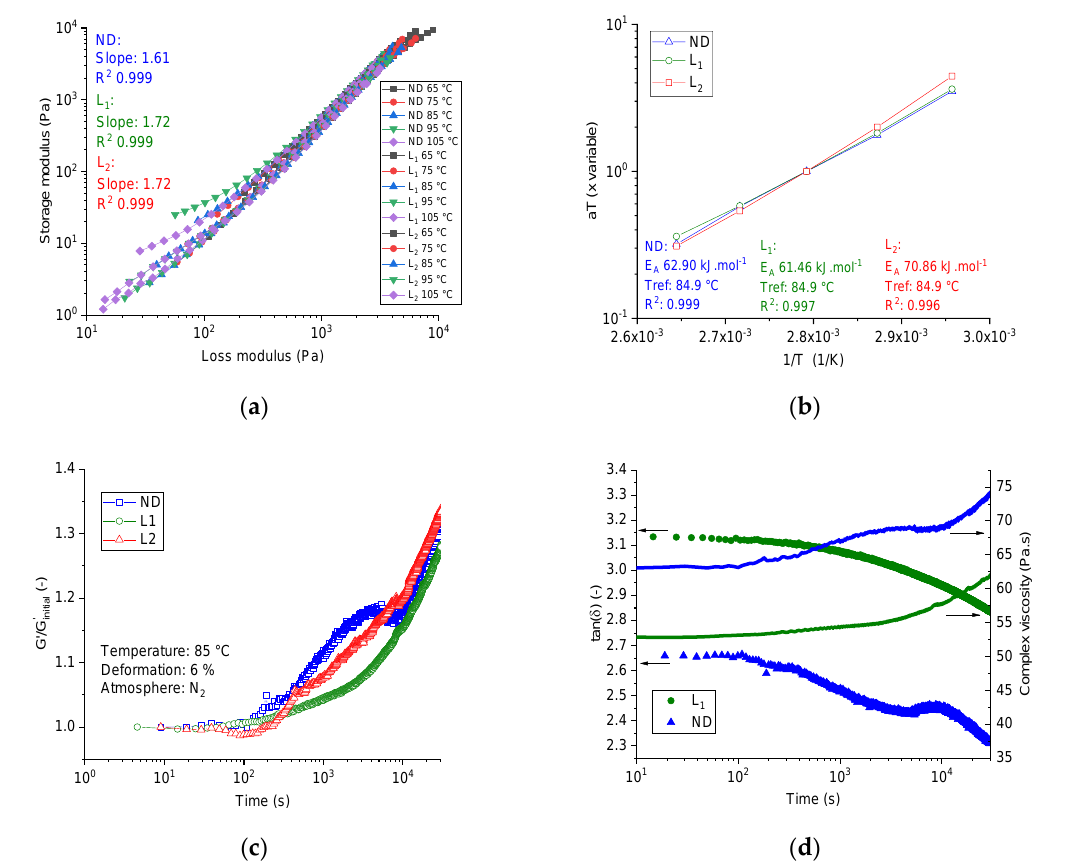
Figure 3. ( a ) Han-plot of the spinning dopes investigated at different temperatures and in the frequency range 0.1–100 Hz; ( b ) time–temperature–superposition (TTS)-Arrhenius plot of the horizontal shift factors versus the temperature at a reference temperature of 85 °C; ( c ) time sweep tests of the developed dopes at 85 °C and 6% deformation; ( d ) development of the loss factor over time at 85 °C from the time sweep tests for the investigated dopes.